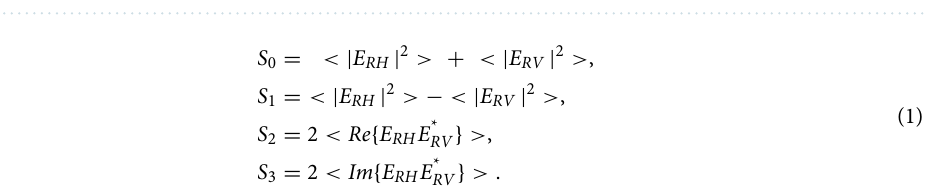
Figure 7. Soil Moisture Analysis: ( a ) Mean difference between mean SM from SMAP original TBs and SM from enhanced SMAP TBs using SMAP-R; ( b ) box plot of the mean and std of the differences between SM products as a function of VOD; and ( c ) comparison of 2018 monthly soil moisture (SM) means for the Core Validation Site (CVS) in Little River, Georgia, with VOD values ranging from 0.363 to 0.559 through the year. All figures made with Matlab R2021b (version 9.11.0.1809720, URL: https:// www. mathw orks. com/ produ cts/ new_ produ cts/ relea se202 1b.